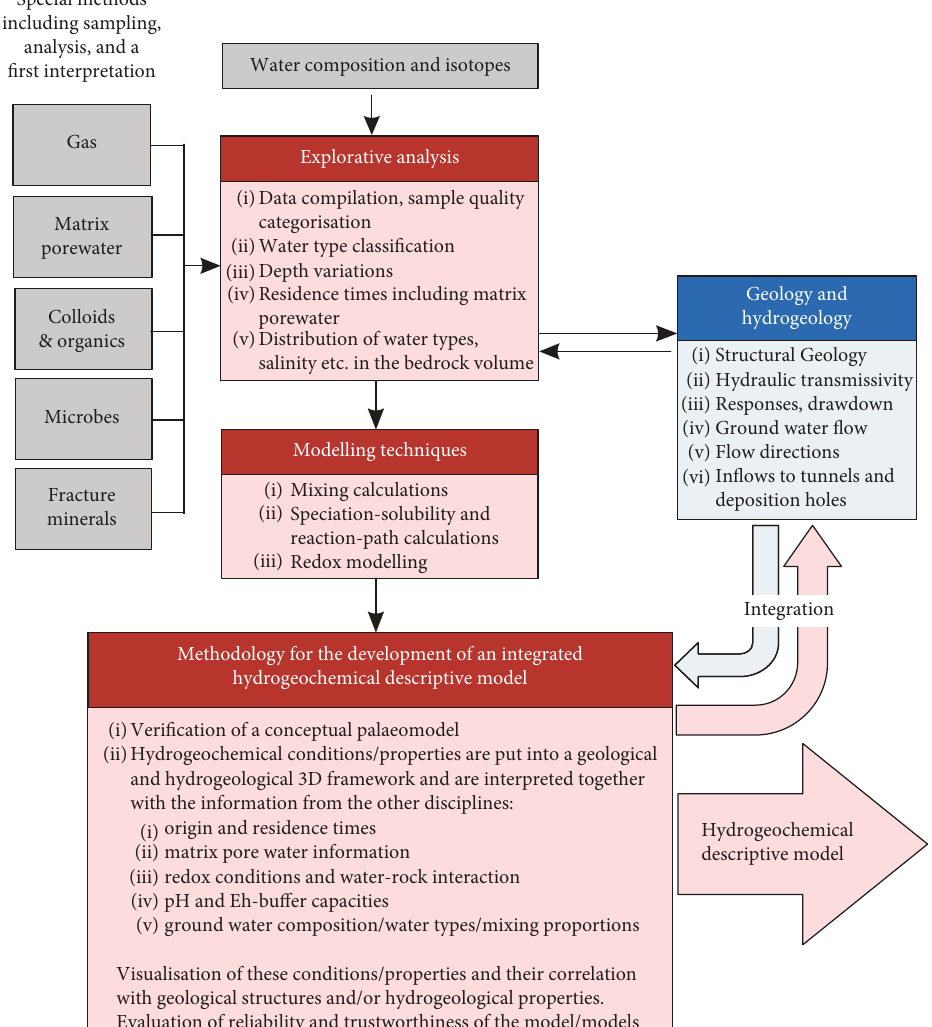
Figure 5: Schematic overview of the interpretation and modelling procedure to produce an integrated hydrogeochemical site model/description. Grey frames are used for hydrogeochemical input data. Blue colour indicates geological and hydrogeological methods and data fl ows, and red boxes indicate descriptive hydrogeochemical interpretation methods, generally performed with speci fi c